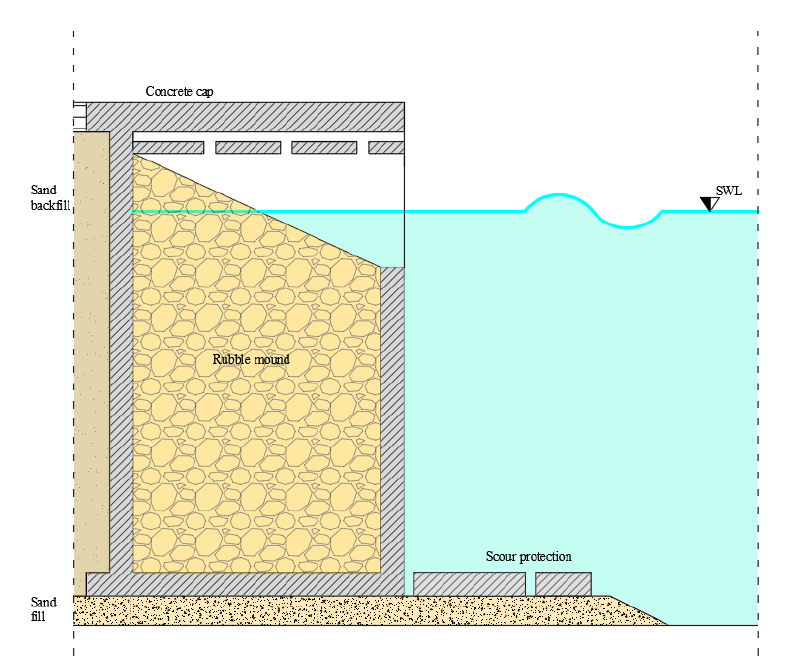
Figure 1. Cross section of a combined